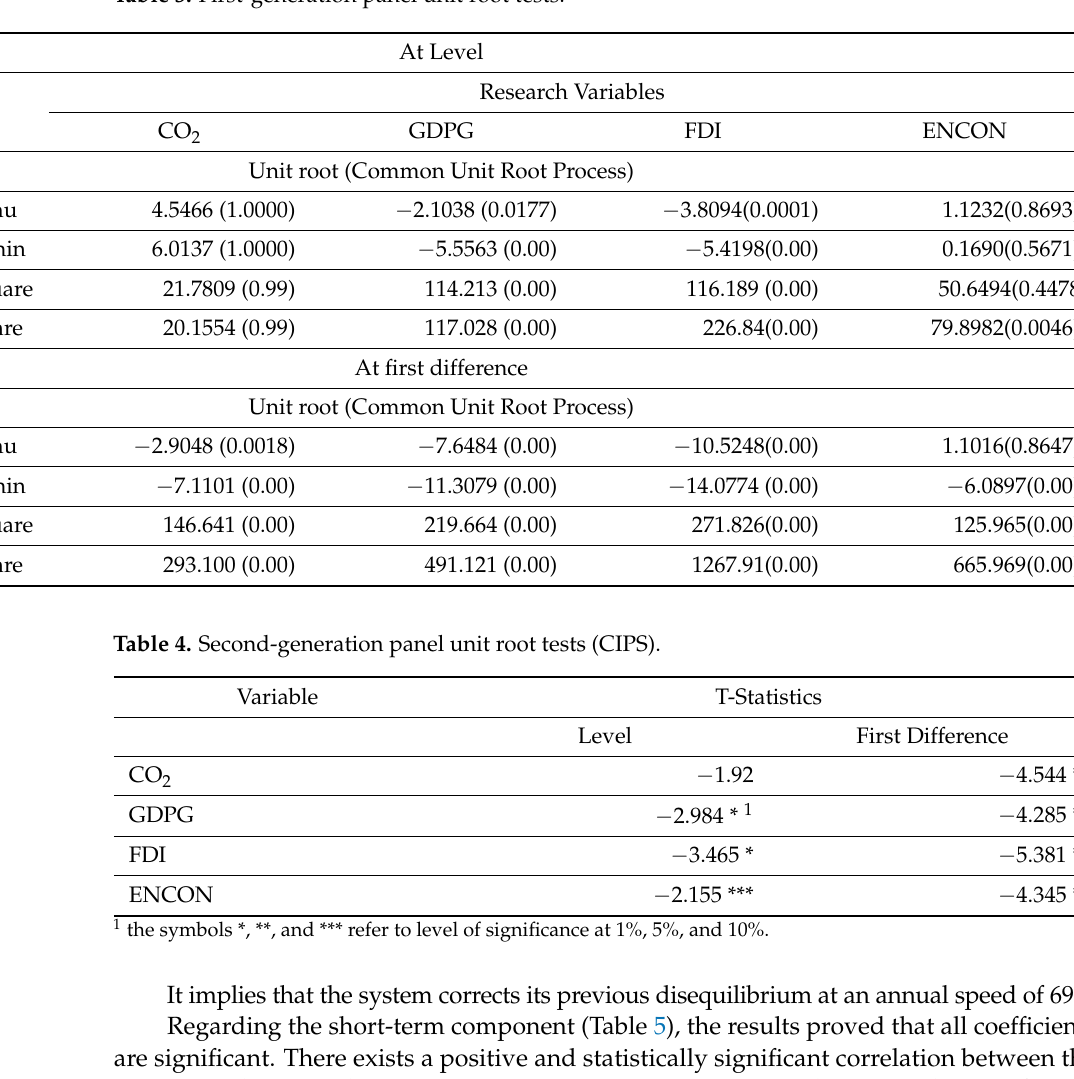
Table 3. First-generation panel unit root tests.